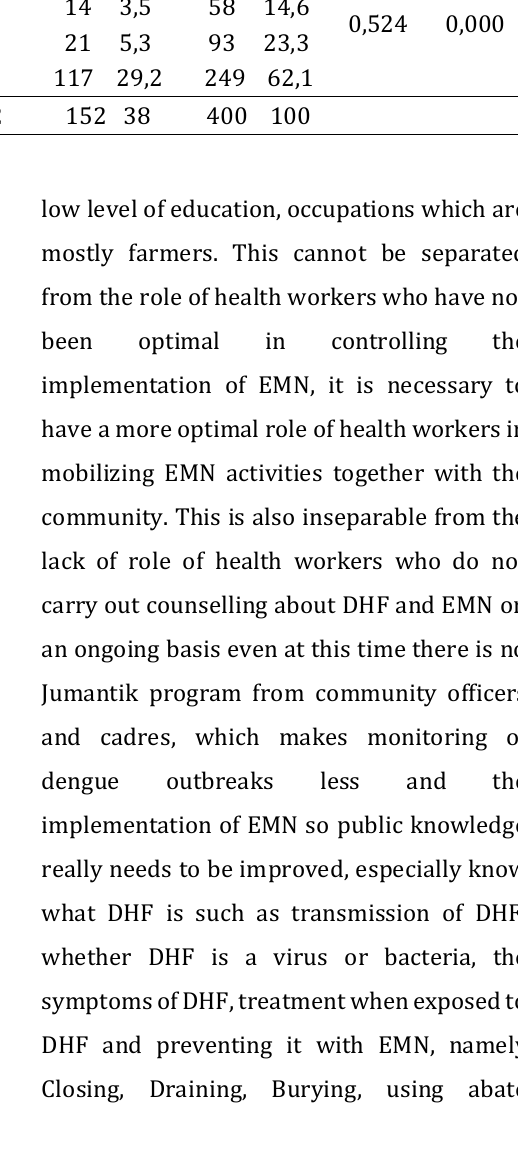
The Relationship between Knowledge Level and Community Behavior in Eradicating Mosquito Nests Behavior Correlation Knowledge Good